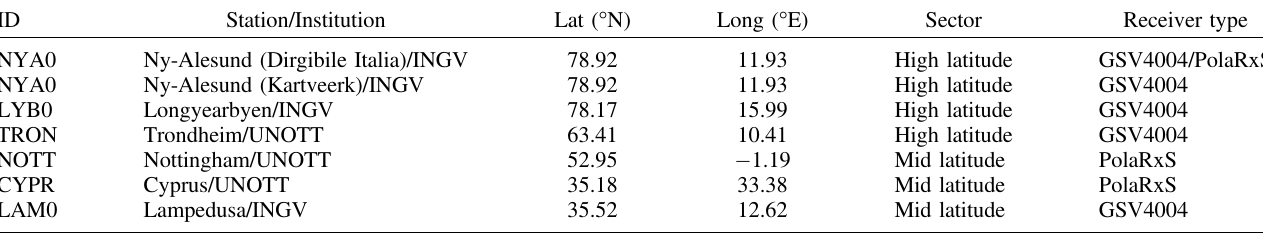
Table 4. List of ISMRs (sampling at 50 Hz) operational in Northern